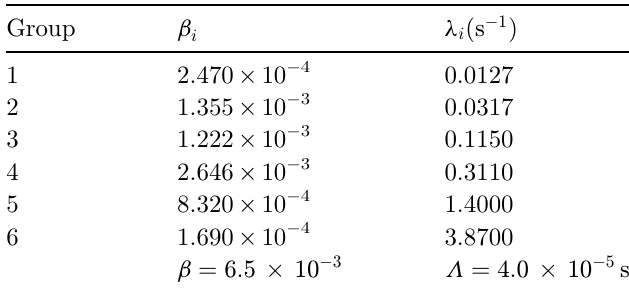
Table 3. Point reactor kinetics model parameters